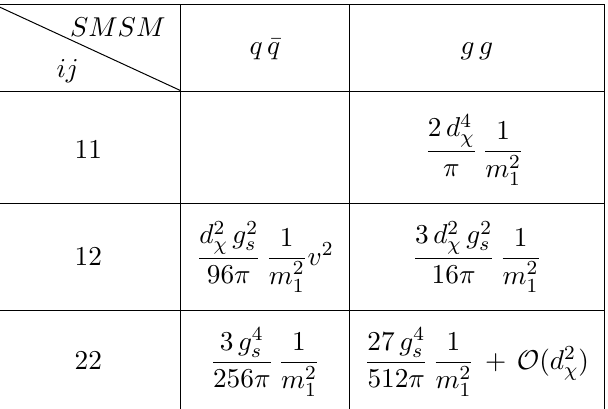
(cid:27)v . The QCD coupling h i (cid:31) i (cid:31) j ! SMSM m =T , (cid:27)v (cid:27)v 1 (cid:17) h i ij (cid:17) h i (cid:31) i (cid:31) j ! SM SM . The relic abundance is then related to this i